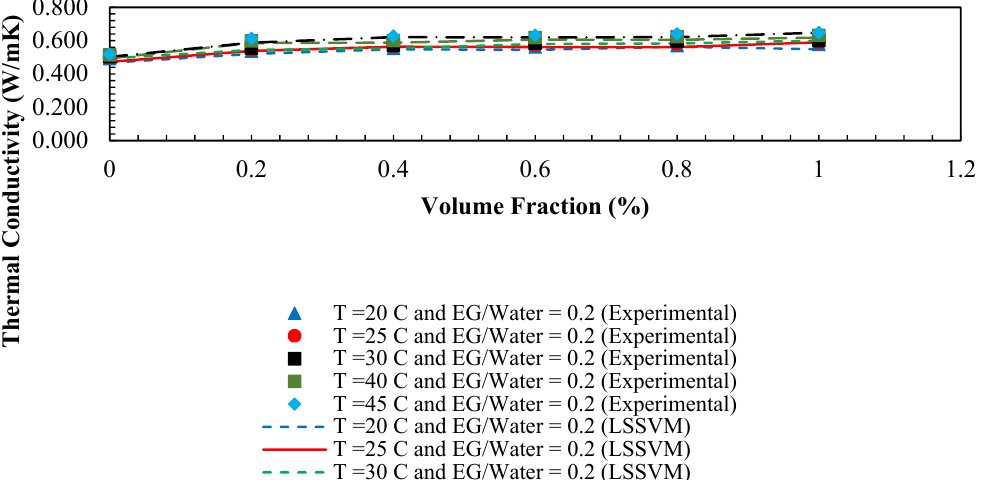
Figure 18. Comparison between predicted and experimental thermal conductivity of Fe 2 O 3 /ethylene glycol-water mixture, versus volume fraction (%) at different condition.